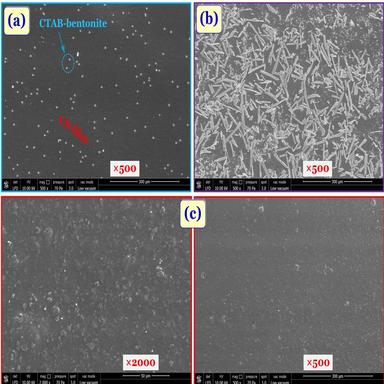
SEM image of the resultant films: (a) CS/(CTAB-bentonite)-5%, (b) CS/(Ag-CTAB-bentonite)-3%, and (c) CS/(Ag-CTAB-bentonite)-5%.